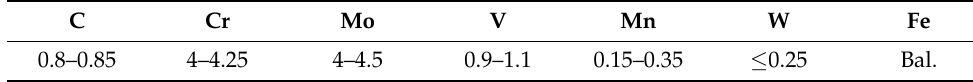
Table 1. Chemical compositions of M50 bearing steel (wt.%).